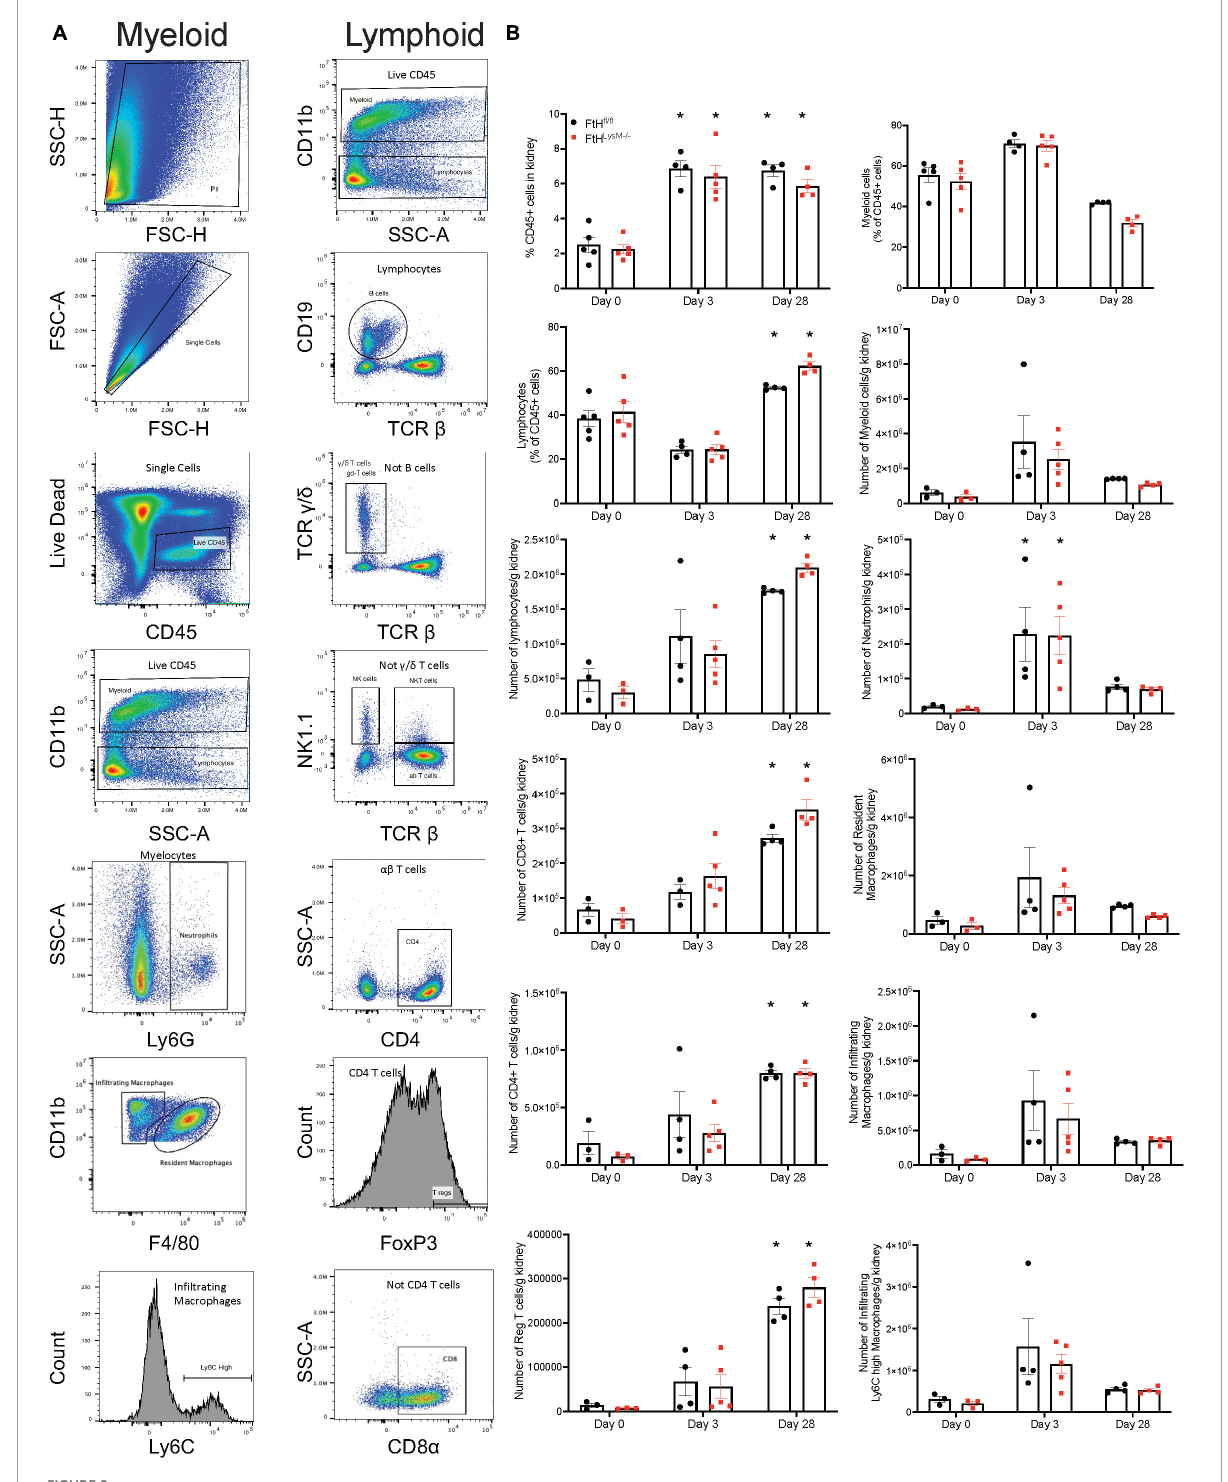
FIGURE8 Myeloid FtH deficiency does not affect rhabdomyolysis-induced accumulation of intra-renal immune cell populations. (A) Representative flow cytometry histograms of kidneys demonstrating the gating scheme to identify immune cell populations. (B) Quantification of the immune cell populations. Data are presented as proportion of CD45+ cells or presented as number of cells per gram kidney and expressed as mean ± SEM. * p < 0.05 vs. baseline